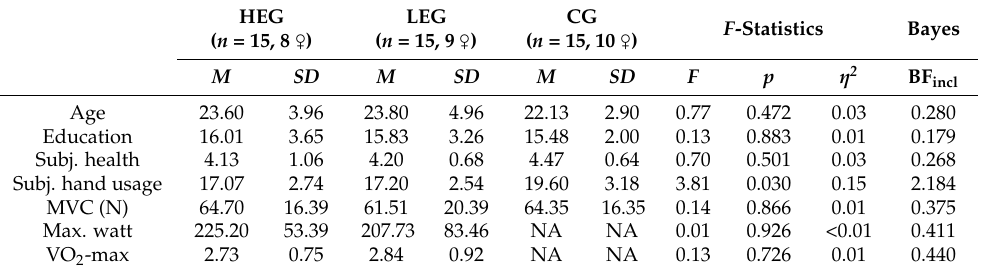
Table 1. Group characteristics and results of one-way ANOVAs for group